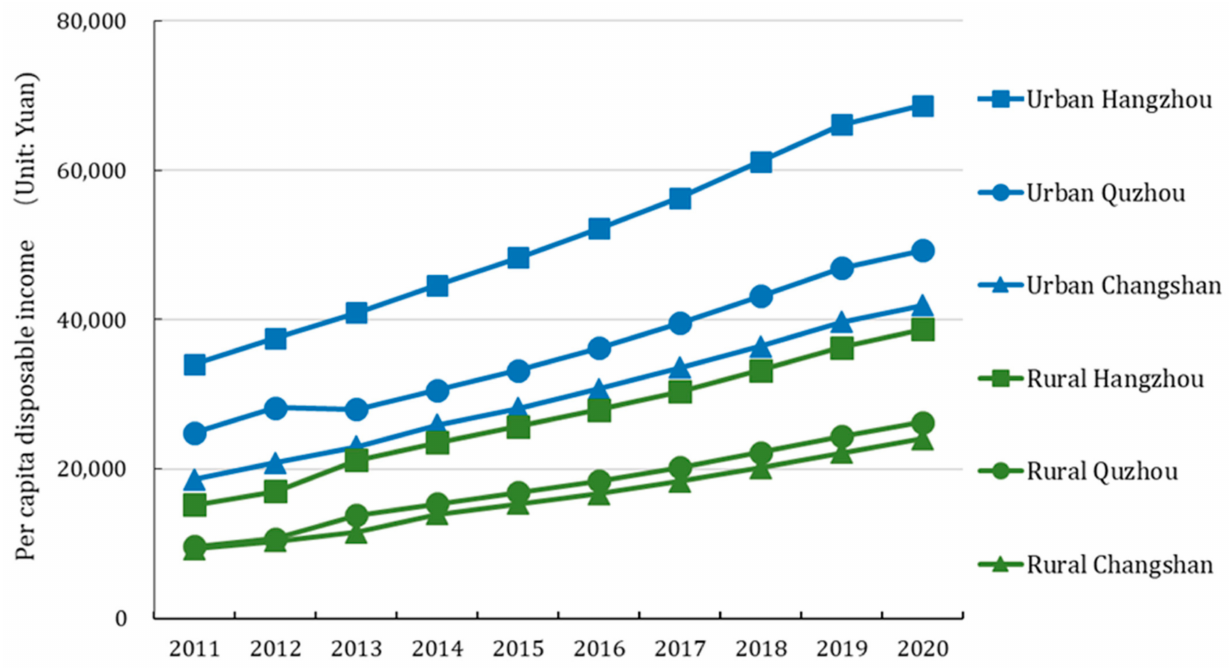
Figure 5. Urban and rural per capita disposable incomes in Hangzhou, Quzhou, and Changshan during